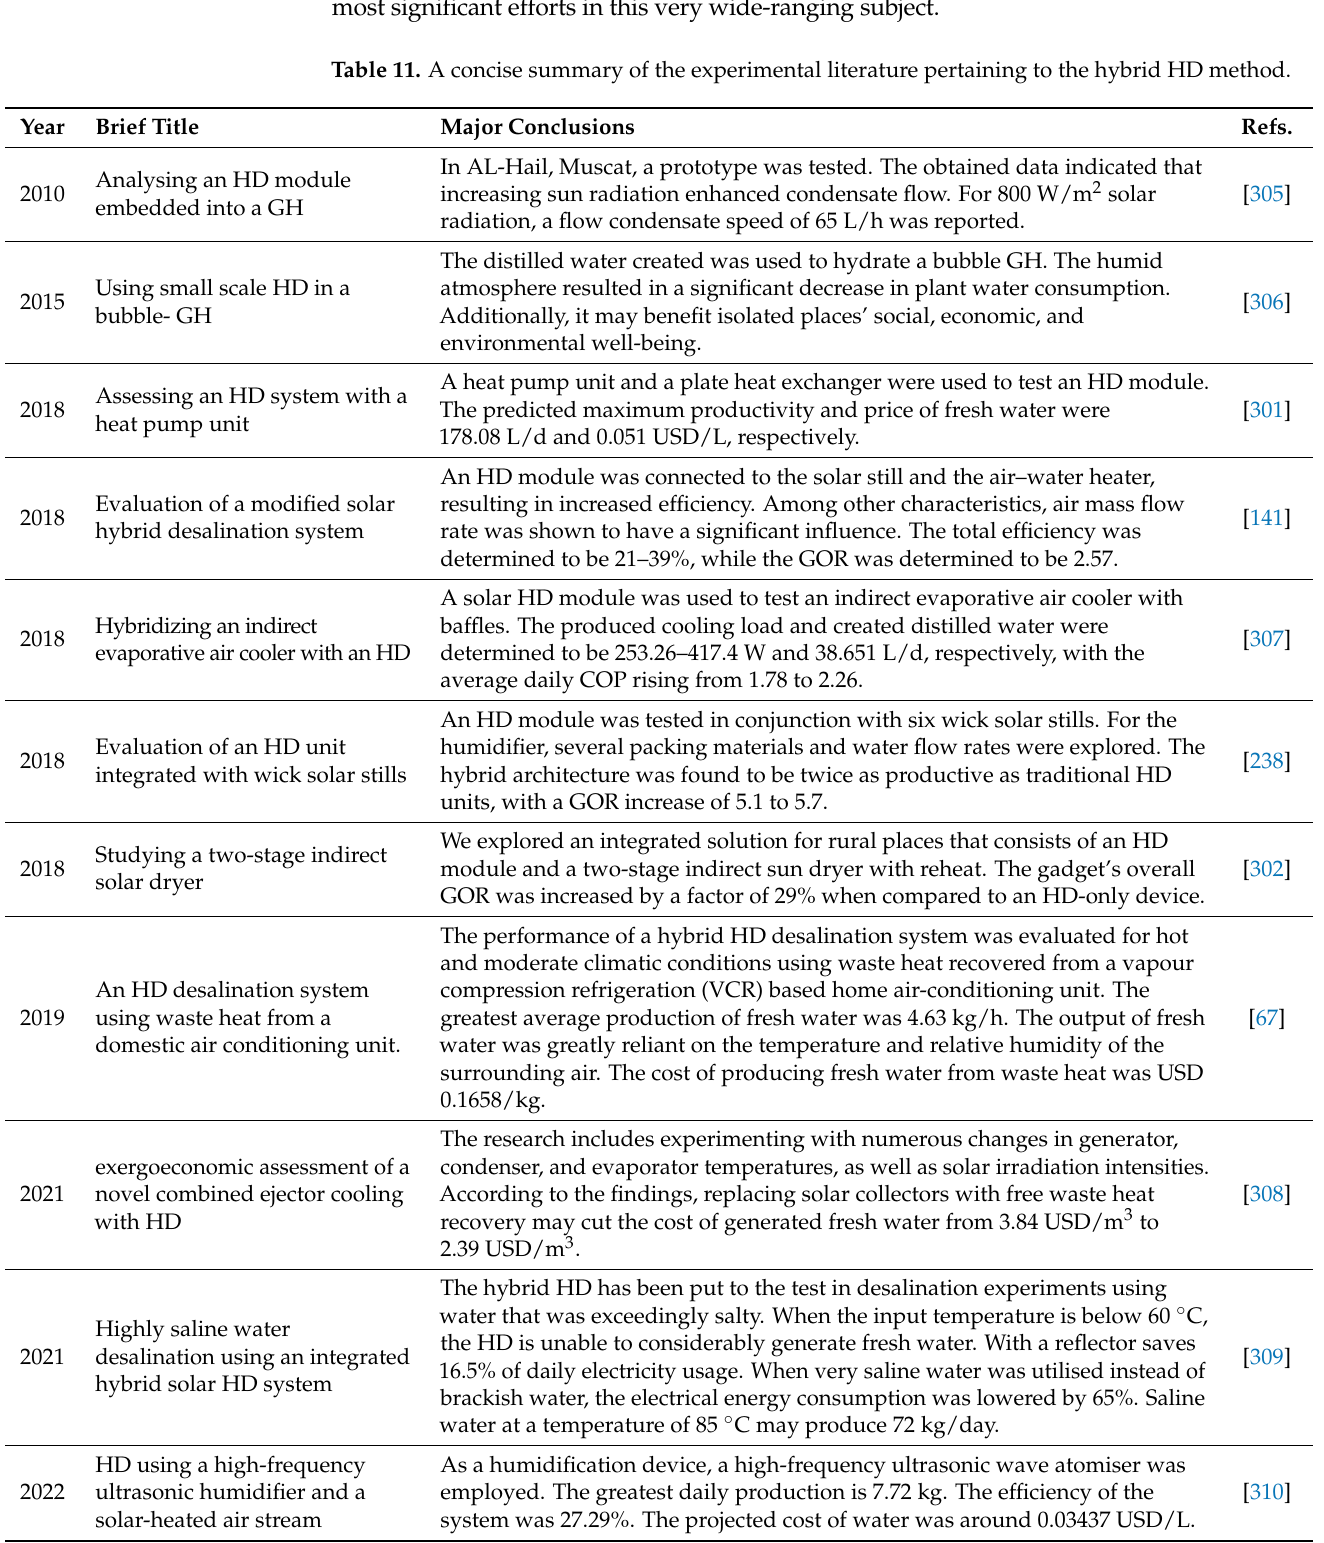
Table 11. A concise summary of the experimental literature pertaining to the hybrid HD